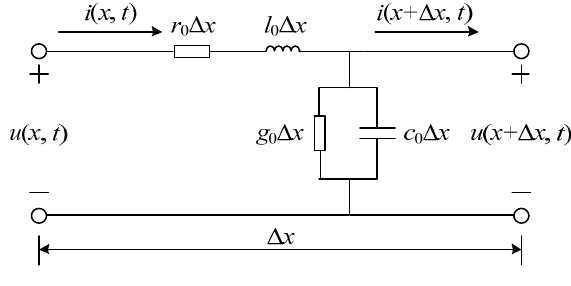
Figure 1. The distributed parameter model.